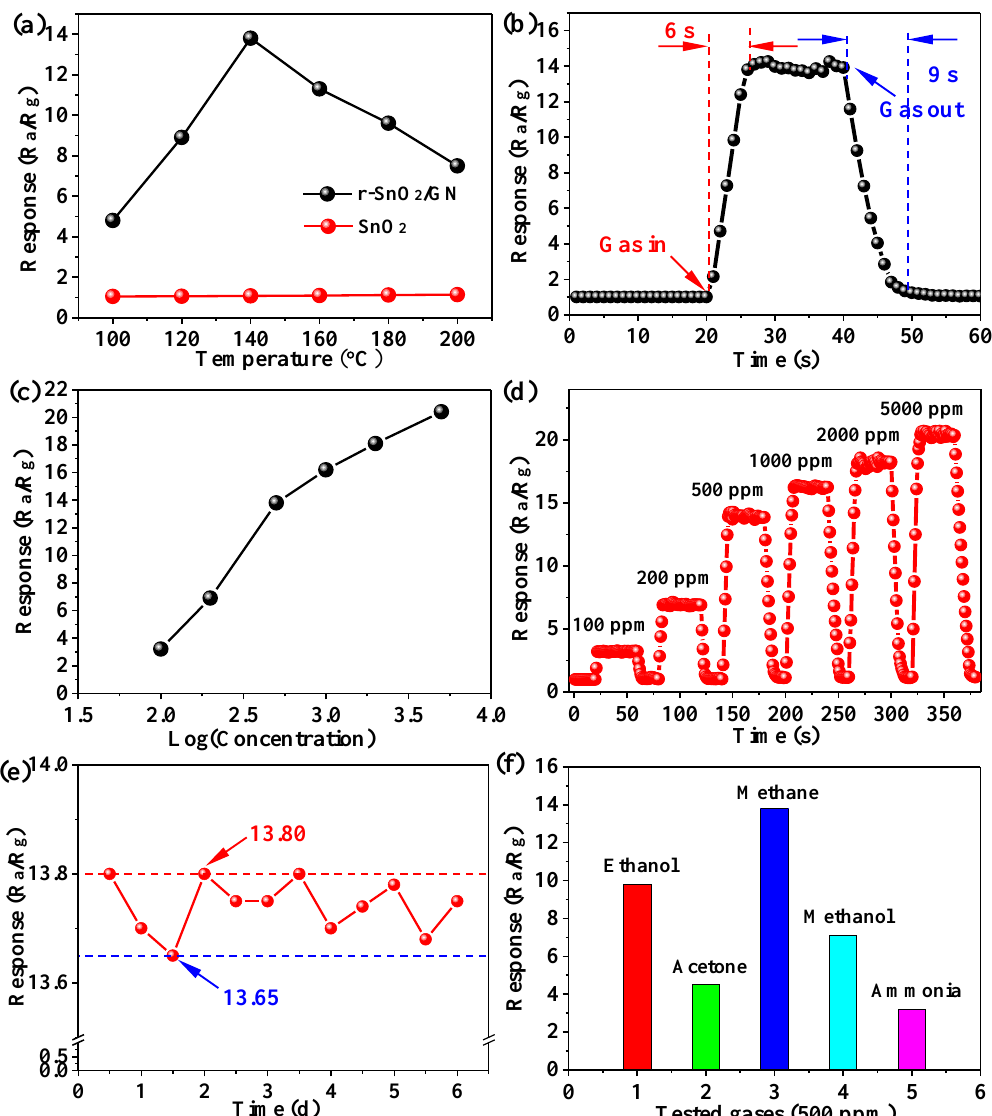
Figure 8. ( a ) Two gas sensors toward methane gas of 500 ppm at different working temperatures; ( b ) A particular response curve of the sensor r-SnO 2 /GN toward methane gas at 140 °C; ( c ) The response value of the sensor r-SnO 2 /GN toward methane gas vs. log(concentration, ppm) and ( d ) the corresponding response curve; ( e ) The stability of the sensor r-SnO 2 /GN toward methane gas at 140 °C; ( f ) The response value of the sensor r-SnO 2 /GN toward various gases.